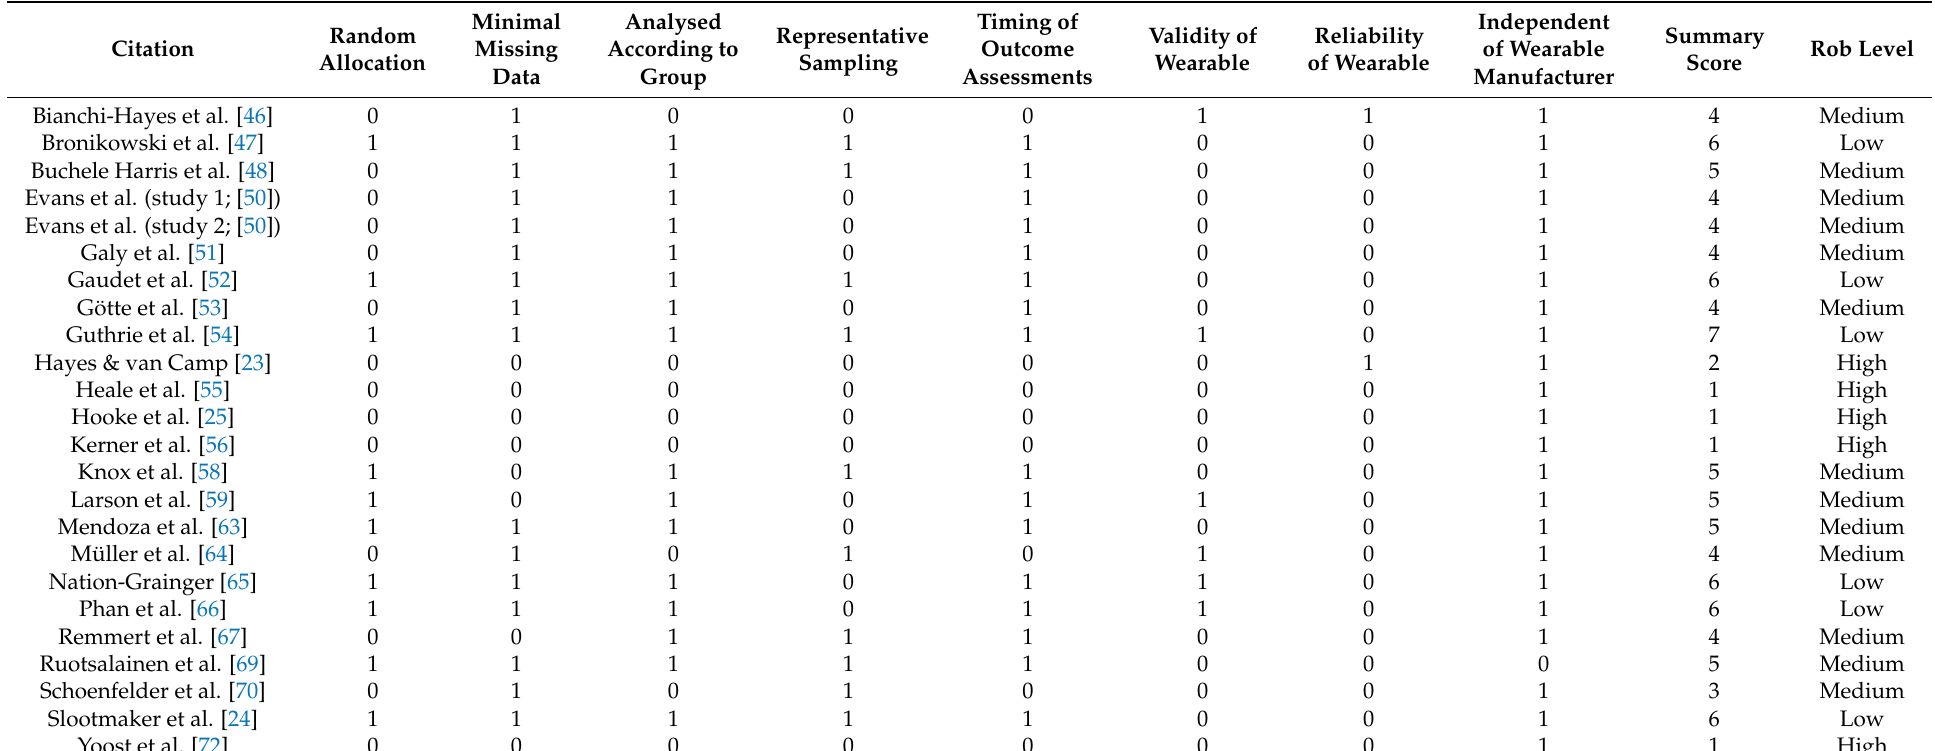
Table 3. Risk of bias results for individual effectiveness